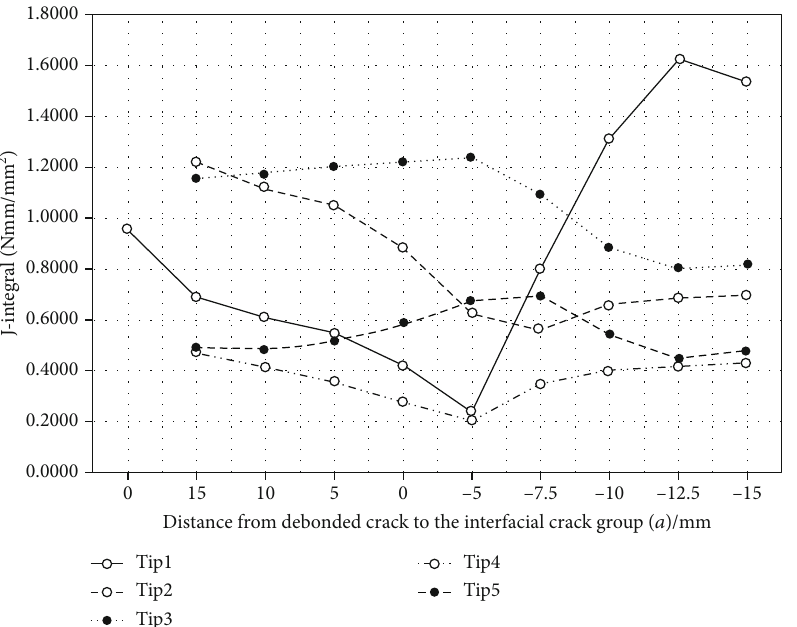
Figure 11: The J -integral variation with the distance of three noncollinear interfacial